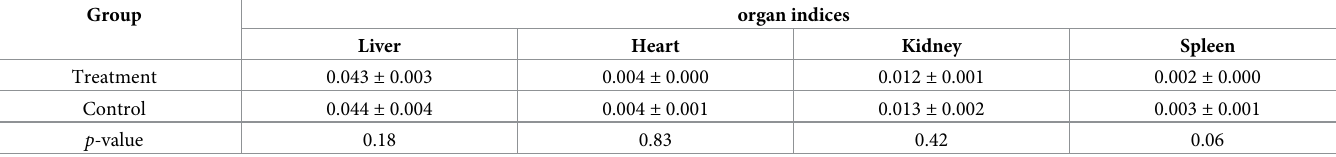
Values are presented as means ± SD. No significant differences were found between the organ indices from the treated group fed with the isolated strain TC1 and the control group ( P > 0.05).